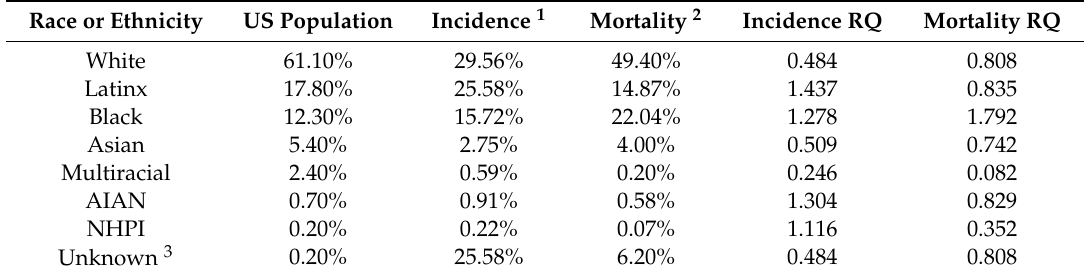
Table 1. US Incidence and Morality Representation Quotients (RQ) for COVID-19 by Race and Ethnicity. US